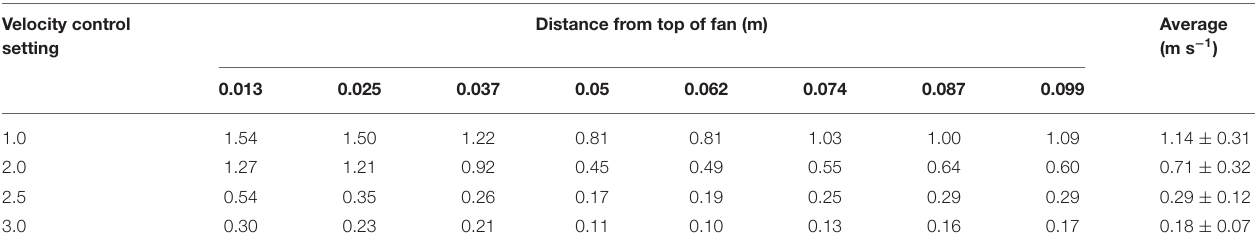
TABLE 1 | Calibration of air velocity. Velocity control